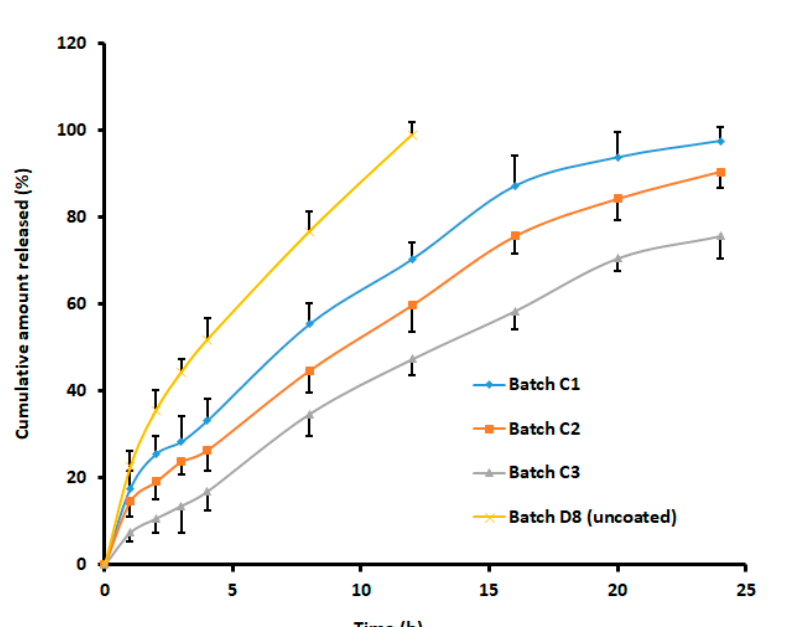
Figure 5. Comparison of cumulative percentage of rivastigmine release from batches with different core-to-coat ratios and control (uncoated). Batch C1 (nanoparticle: eudragit, 1:1), batch C2 (nanopar- ticle: eudragit, 1:3), and batch C3 (nanoparticle: eudragit, 1:5). The data represent an average ± SD of six trials.